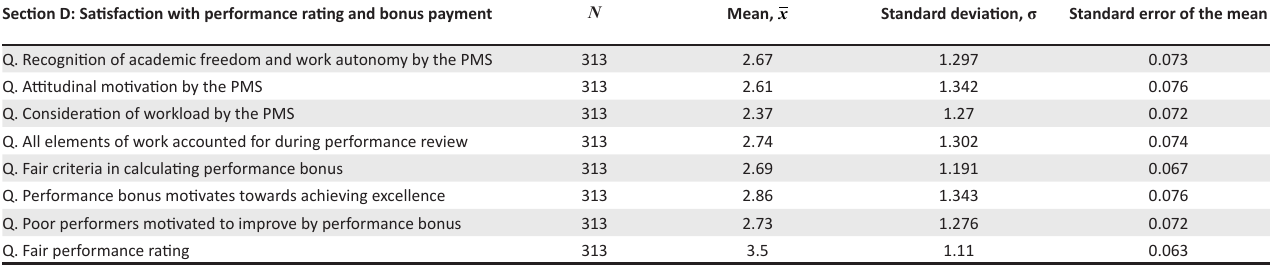
TABLE 4: Results of one-sample t-test statistics for Section D of the measuring instrument. Section D: Satisfaction with performance rating and bonus payment N Mean, x Standard deviation,